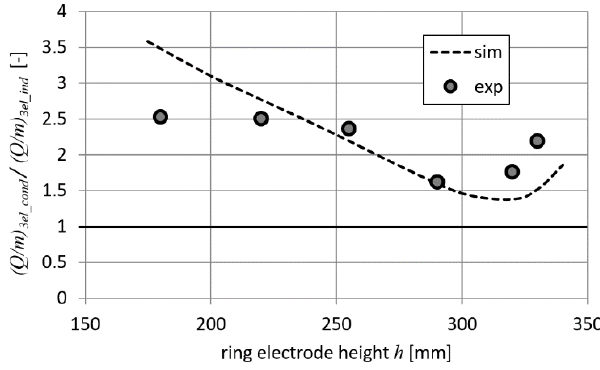
Figure 14. Ratio of measured (“exp”) and calculated (“sim”) Q / m parameter values for both conduction ( Q / m ) 3 el_cond and induction ( Q / m ) 3 el_ind methods in the 3-electrode system.